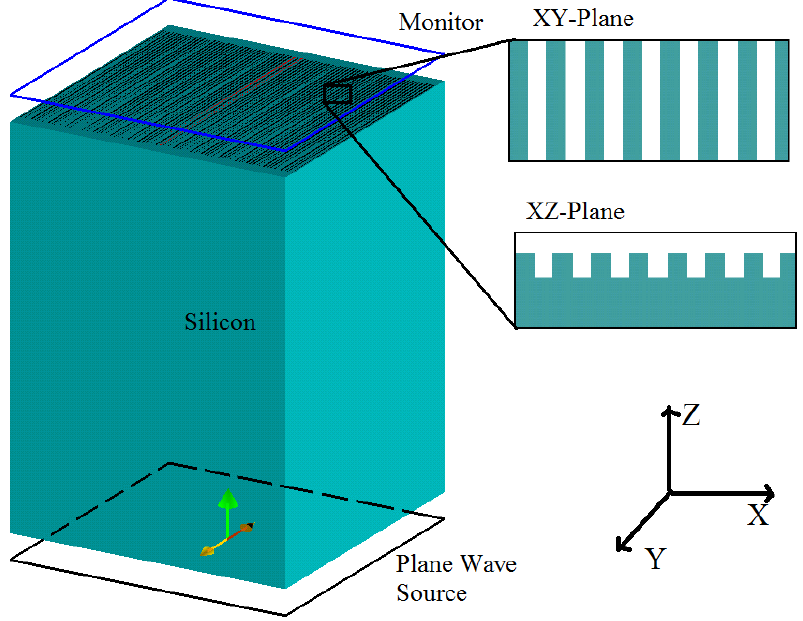
Figure 1. Gratings structure model used in the Lumerical FDTD simulation software.